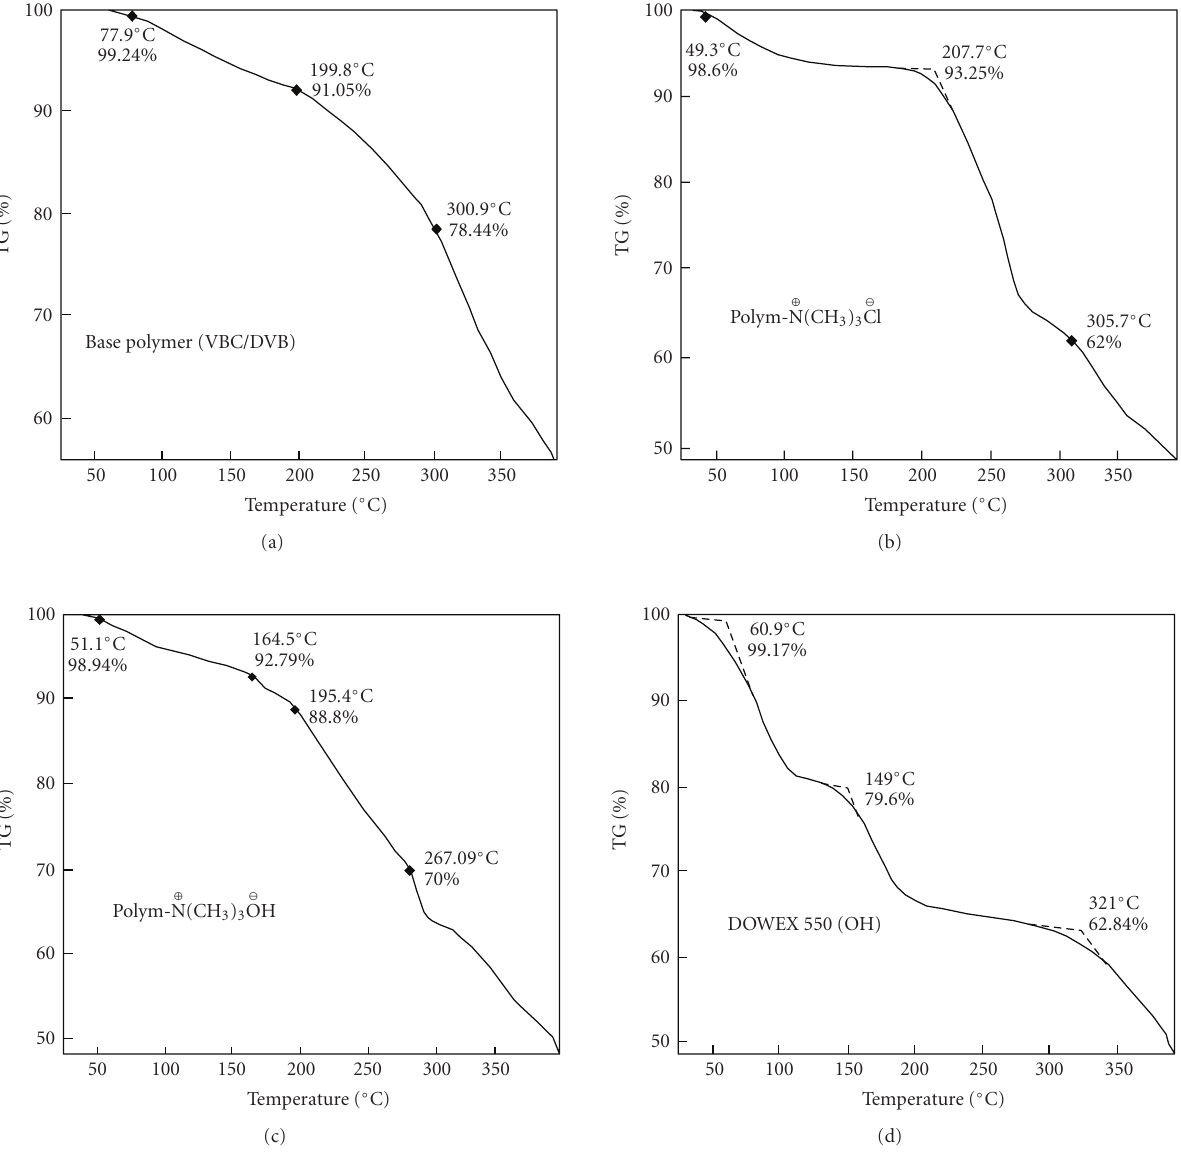
Figure 8: Thermogravimetric curves (5 ◦ C/min, air) for base polymer, P-N(CH 3 )